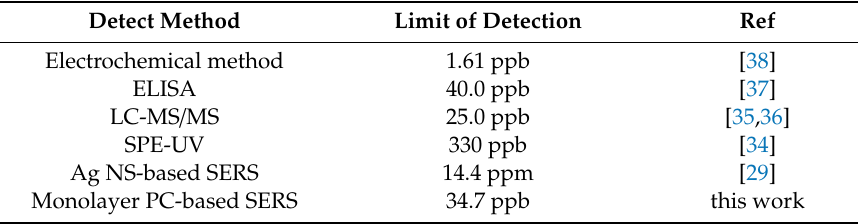
Table 1. Sensitivity comparison of a monolayer PC substrate-based SERS assay of thiram pesticides with other